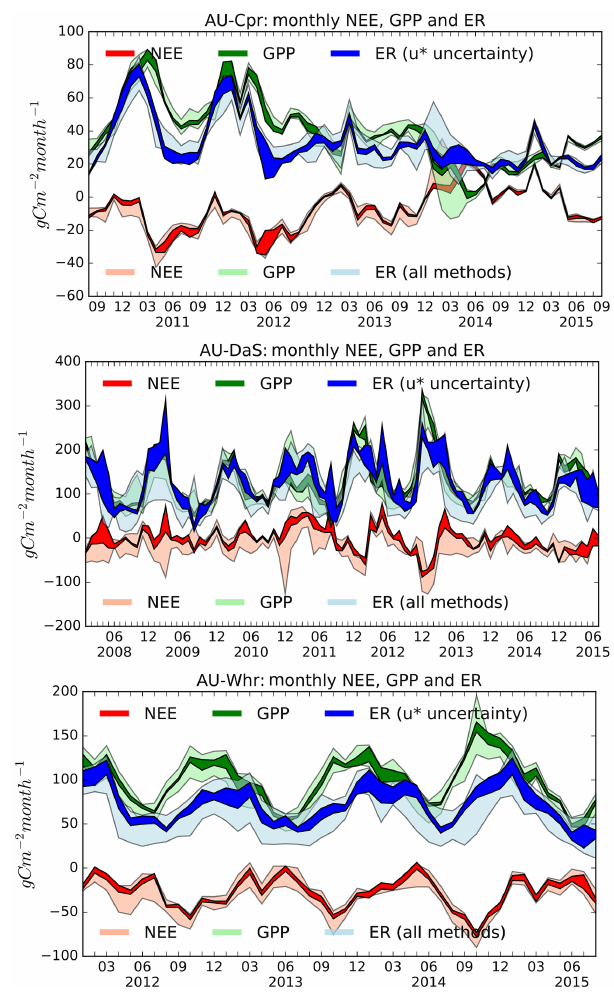
Figure 9. Time series of monthly sums of NEE (red), GPP (green) and ER (blue) at the Calperum (AU-Cpr, top), Daly Savanna (AU- DaS, middle) and Whroo (AU-Whr, bottom) sites. Dark colours show the range of values due to uncertainty in the u ∗ threshold (OzFluxQC, nocturnal Lloyd–Taylor approach), while light colours show the range of values across all seven methods used in Fig.